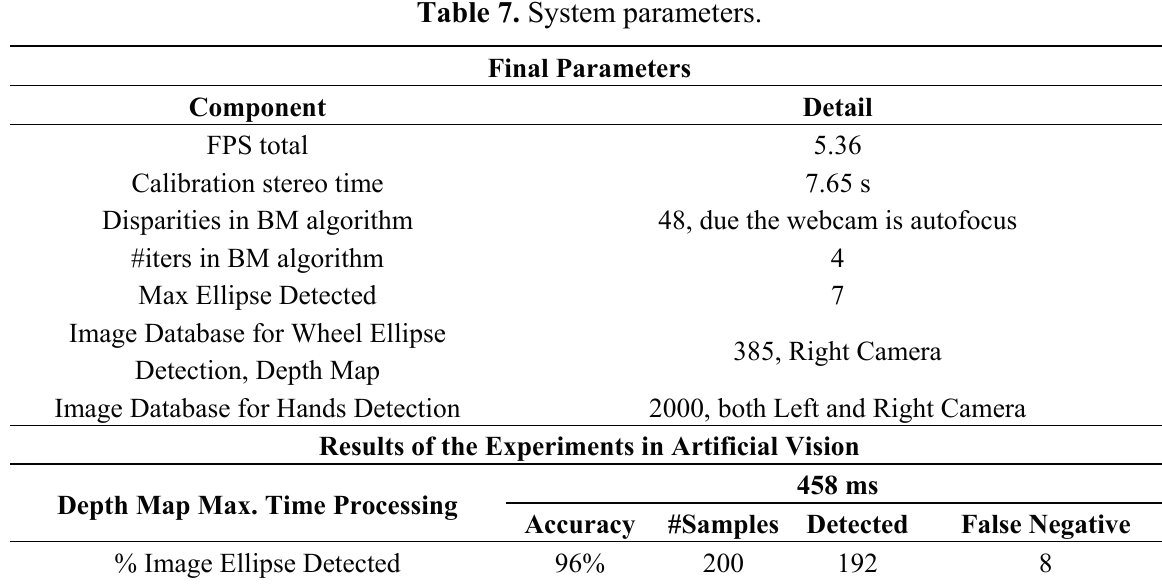
Table 7. System parameters.